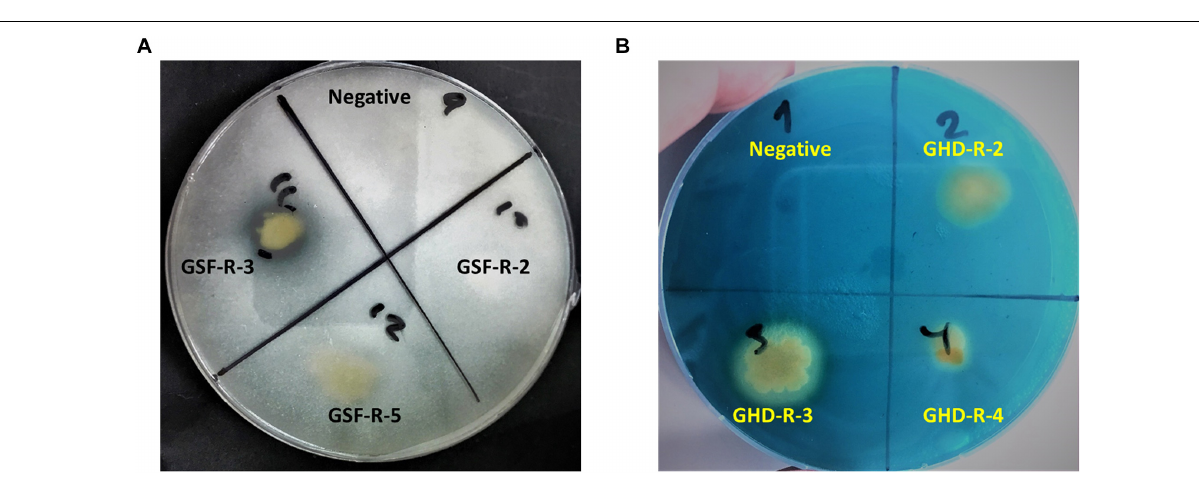
than 12 µ g/ml) when compared with strains from other locations ( Supplementary Table S6